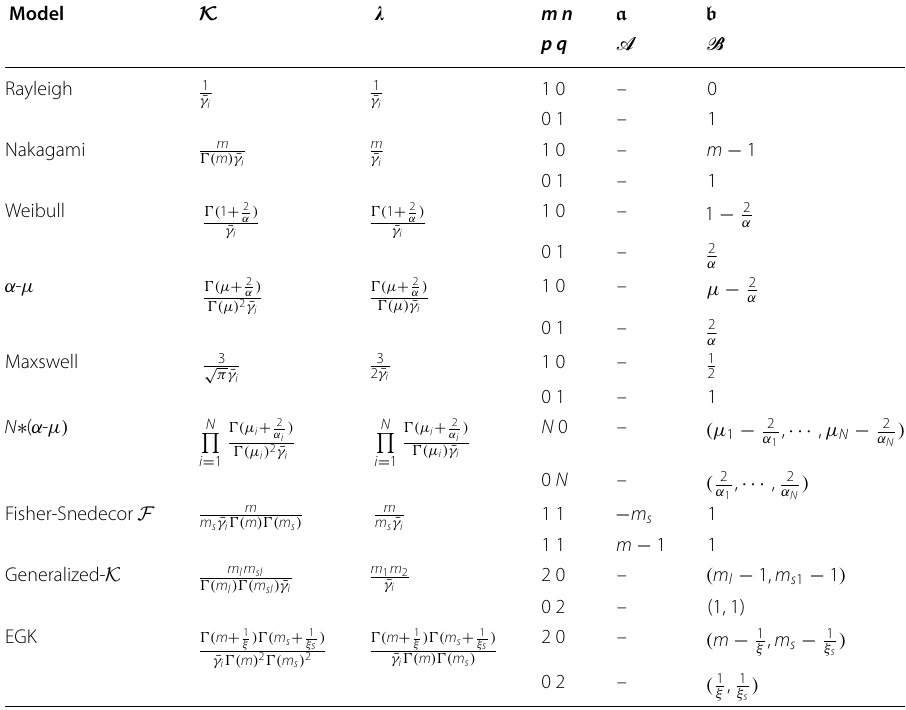
Table 3 Fox’s H -equivalents of typical and generalized statistical models for instantaneous received B , E SNR γ i , i , and γ i is the average SNR ∈ { } ¯ Model K